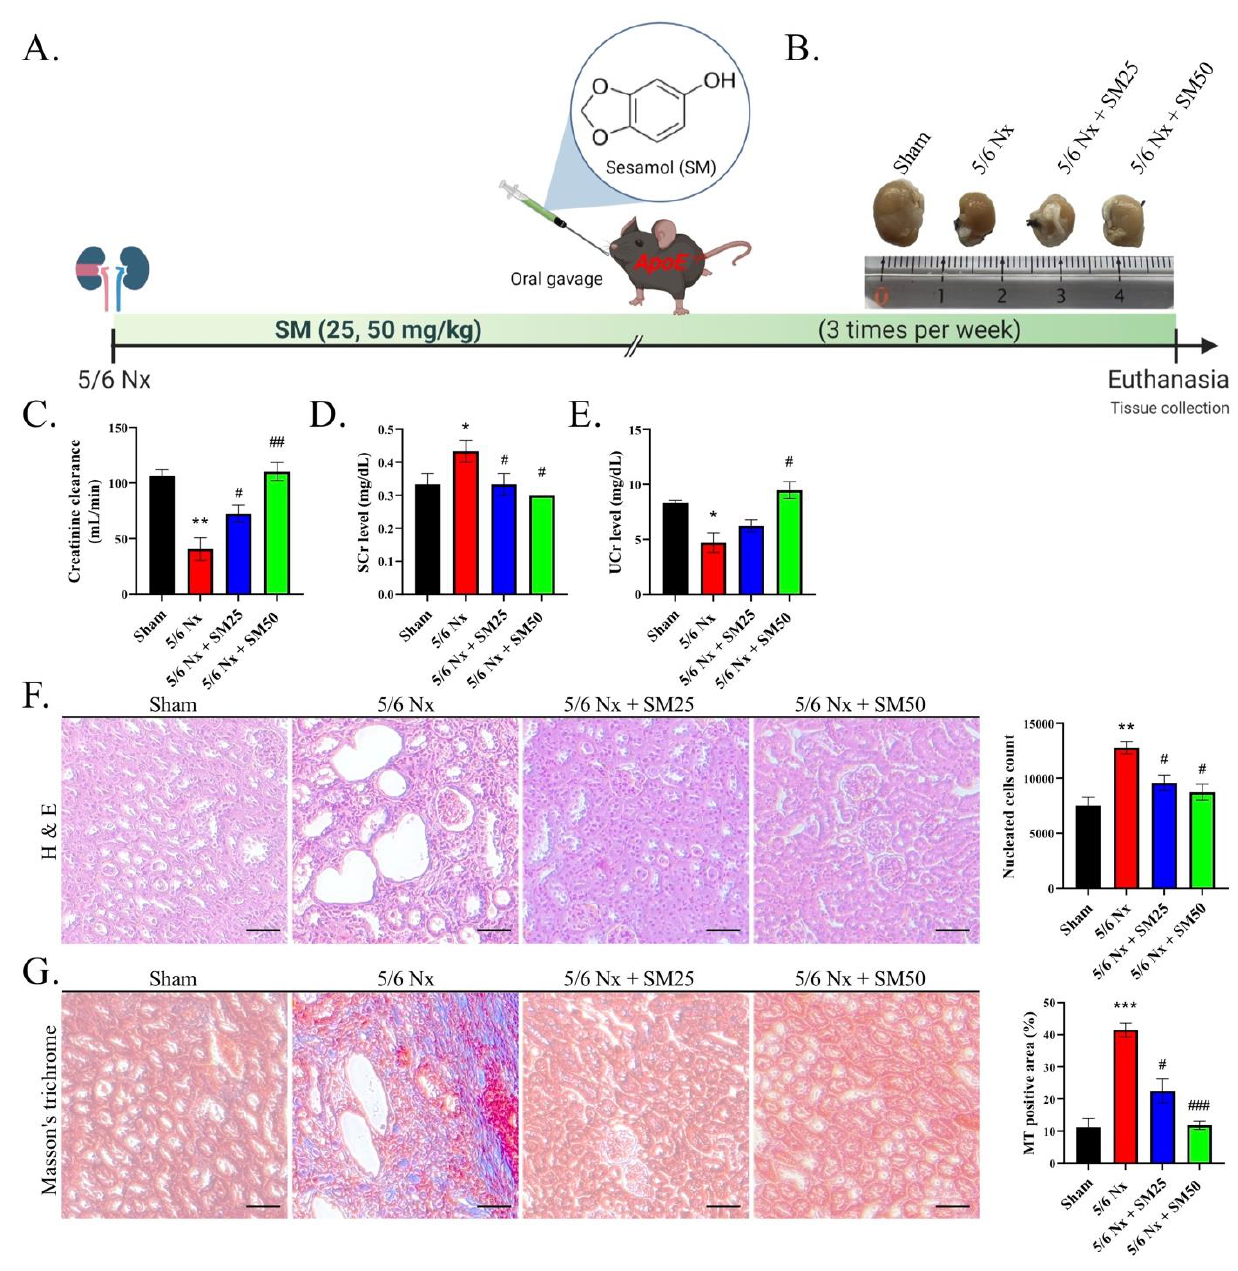
Figure 1. Evaluation of renal function and histopathology after eight weeks of 5/6 Nx. ( A ) Schematic representation of the 5/6 nephrectomy model of the ApoE −/− mice ( n = 6 per group). ( B ) Representative images of the kidneys from each group. ( C ) Creatinine clearance, ( D ) serum creatinine (Scr), and ( E ) urine creatinine (Ucr). Creatinine clearance was evaluated by collecting urine after 24 h. The urine and serum creatinine levels in the mice were measured after different treatments. ( F ) Observation and calculation of changes in the glomerular tuft architecture, glomerular microvascular lipid accumulation, and infiltration of immune cells (nucleated cells) in the kidneys (H&E staining) (200×); scale bar = 100 μ m. ( G ) Images of kidney tissues with Masson’s trichrome staining. Masson’s trichrome-stained positive area; scale bar = 100 µ m. Data are expressed as the mean ± SEM ( n = 6). * p < 0.05, ** p < 0.01, *** p < 0.001 vs. sham group. # p < 0.05, ## p < 0.01, ### p < 0.001 vs. 5/6 Nx group.